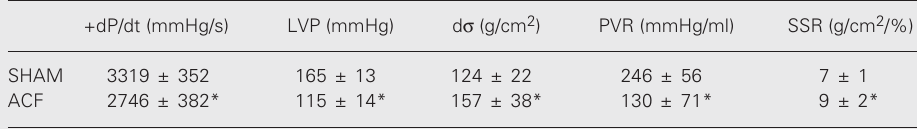
Table 4. Isolated heart systolic function indexes in a chronic volume overload